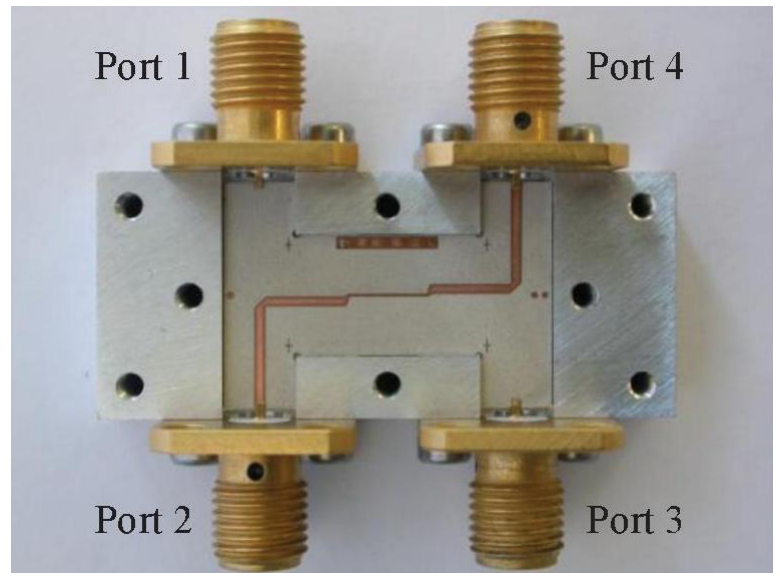
Figure 8. Partly assembled hybrid